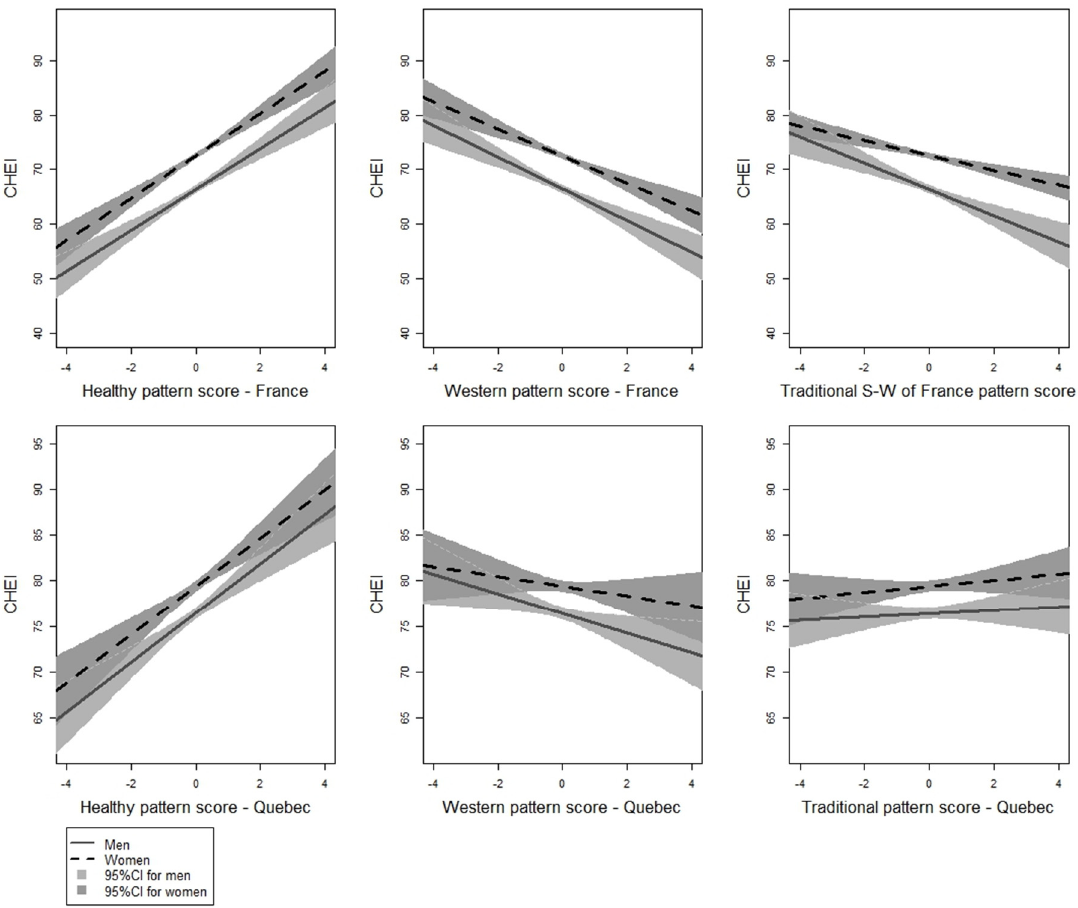
Figure 1. Linear relationships between energy-adjusted nutrient pattern scores and C-HEI scores by sex ( n 3C = 1712. n NuAge = 1596)*. * For reasons of clarity, 21 subjects in 3C and 12 subjects in NuAge are not presented in their respective traditional pattern score plots.